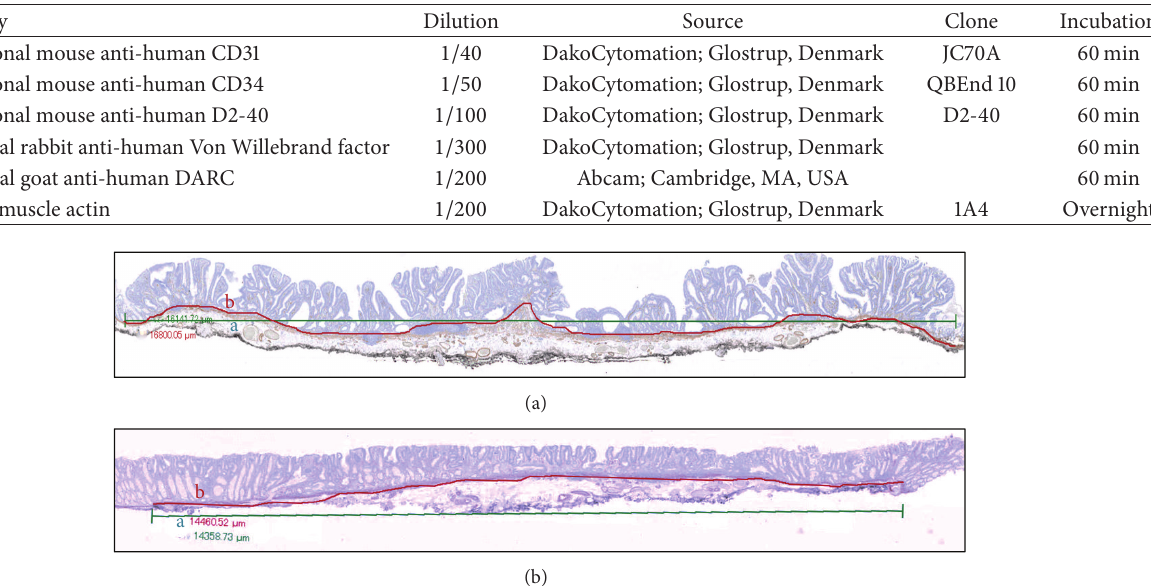
Table 1: Antibodies used in the study.